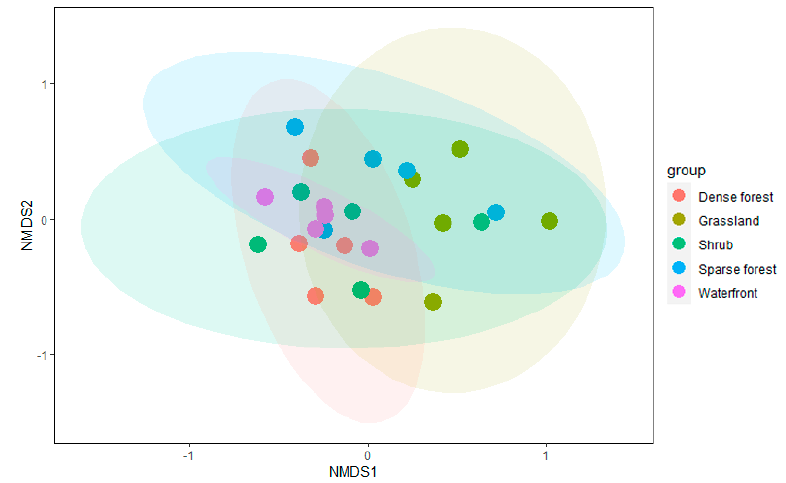
Figure 7. Differences in bird community composition for 25 sampled transects (five dense forest habitats = red circles, five sparse forest habitats = blue circles, five grassland habitats = brown circles, five shrub habitats = green circles, and five waterfront habitats = purple circles) in five different vegetation habitats in urban mountain parks.